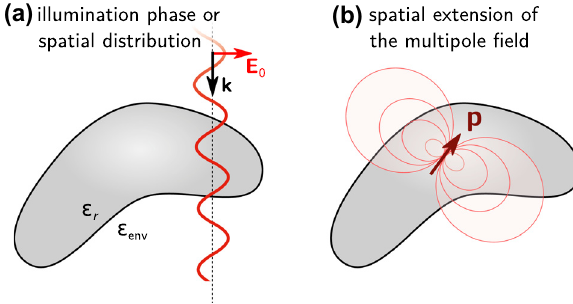
Figure 1: The long wavelength approximation describes structures which are very small compared to the wavelength. If the structures become larger the phase and field distribution over its volume cannot be assumed constant any longer. Retardation effects influence the multipole expansion at two levels: (a) the true spatial variations of the illumination field and its phase across the nanostructure and (b) the spatial distribution of the field emitted by the multipoles in the